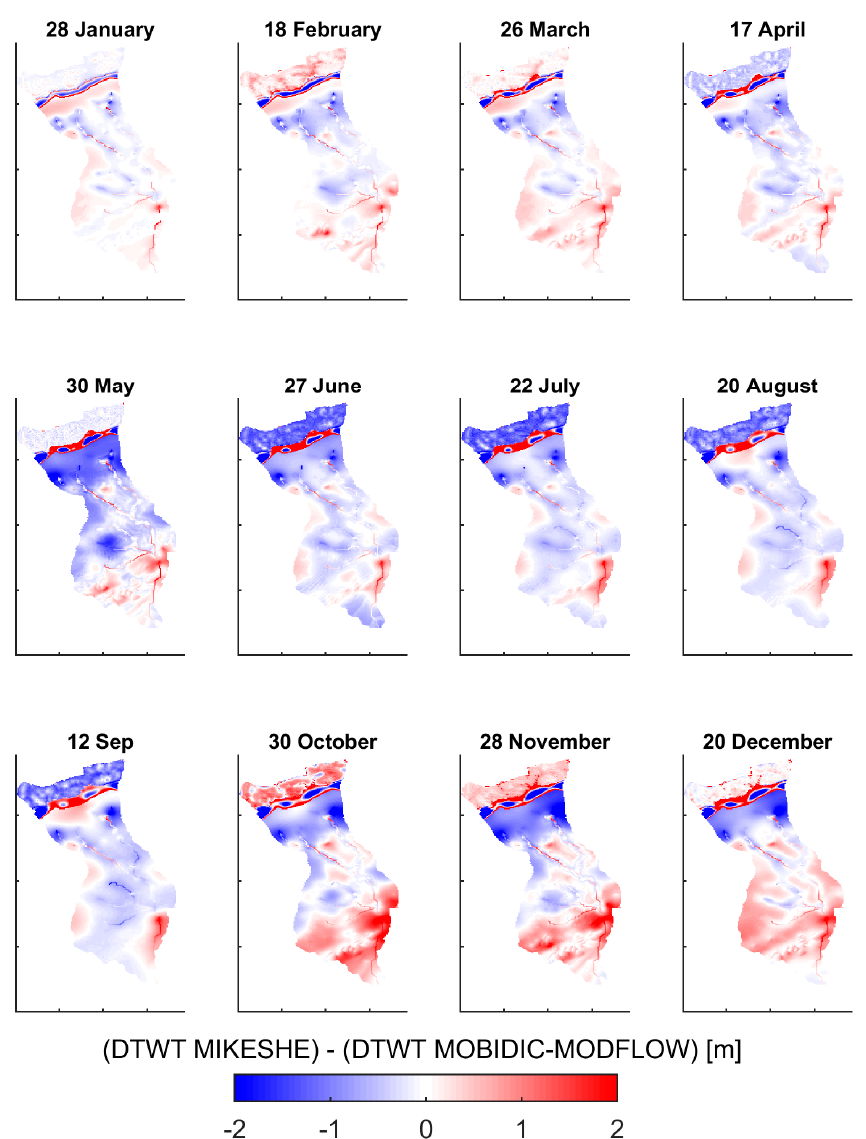
Figure 15. Temporal variation of the differences in depth to water table levels of MOBIDIC-MODFLOW and MIKE SHE. Positive values: deeper water table with MOBIDIC-MODFLOW; negative values: shallower water table depths with MOBIDIC-MODFLOW.